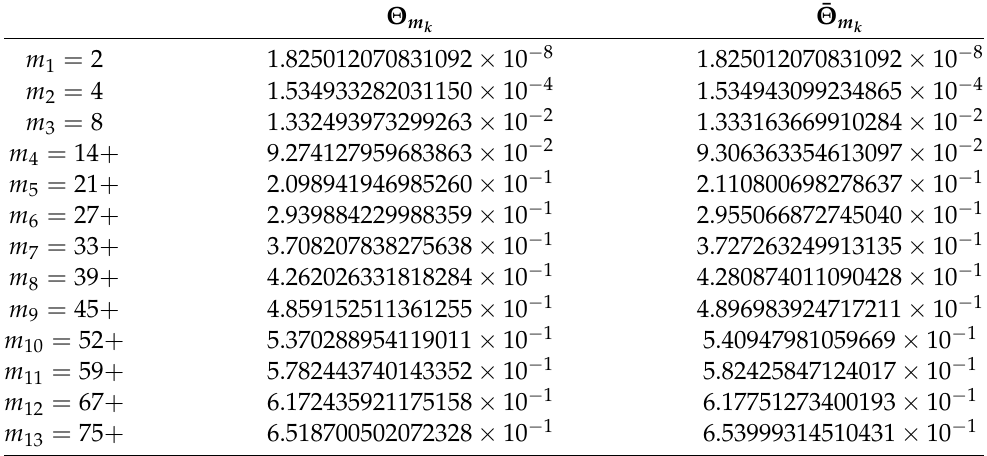
Table 3. Values Θ m analyses,